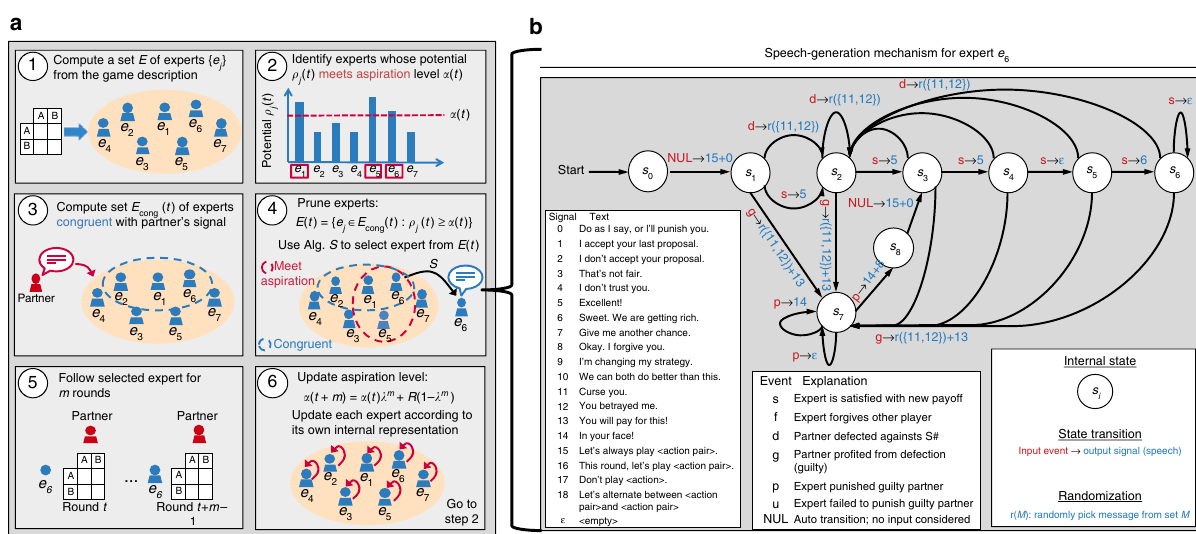
Fig. 3 An overview of S#. S# extends S++ 37 with the ability to generate and respond to cheap talk. a S# ’ s algorithmic steps. Prior to any interaction, S# uses the description of the game to compute a set E of expert strategies (step 1). Each expert encodes a strategy or learning algorithm that de fi nes both behavior and speech acts (cheap talk) over all game states. In step 2, S# computes the potential, or highest expected utility, of each expert in E . The potentials are then compared to an aspiration level α ( t ), which encodes the average per-round payoff that the algorithm believes is achievable, to